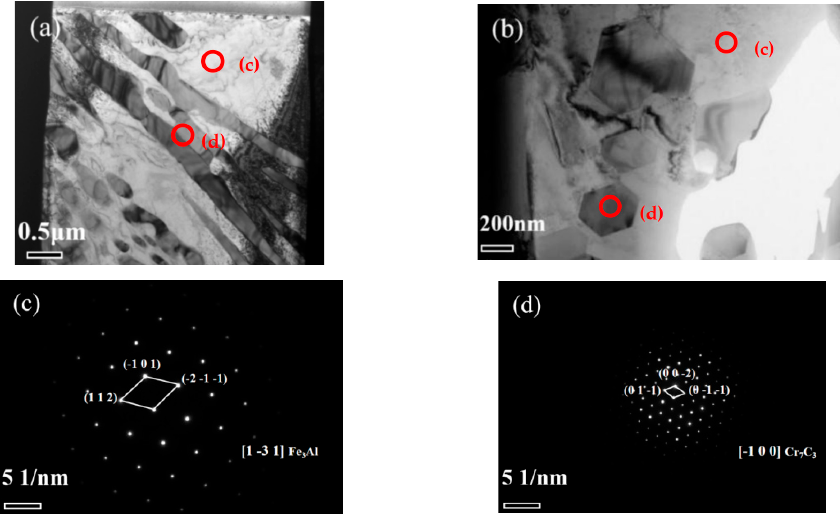
Figure 4. TEM morphology and selected electron diffraction patterns of 15 and 35 wt.% Cr 3 C 2 cladding layers. Microstructure morphology of ( a ) 15 wt.% Cr 3 C 2 cladding layer and ( b ) 35 wt.% Cr 3 C 2 cladding layer. Diffraction patterns of ( c ) Fe 3 Al/Fe 2 AlCr in the [1–31] crystal band direction and ( d ) Cr 7 C 3 in the [ − 100] crystal band direction.